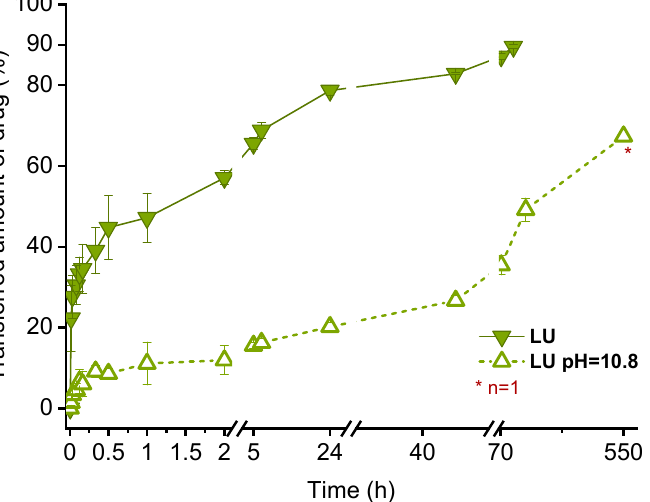
Figure 7. Comparison of lumefantrine transfer before (same data as in Figure 6 but different abscissa scaling) and after pH adjustment. Each value represents mean ± standard deviation ( n = 3).